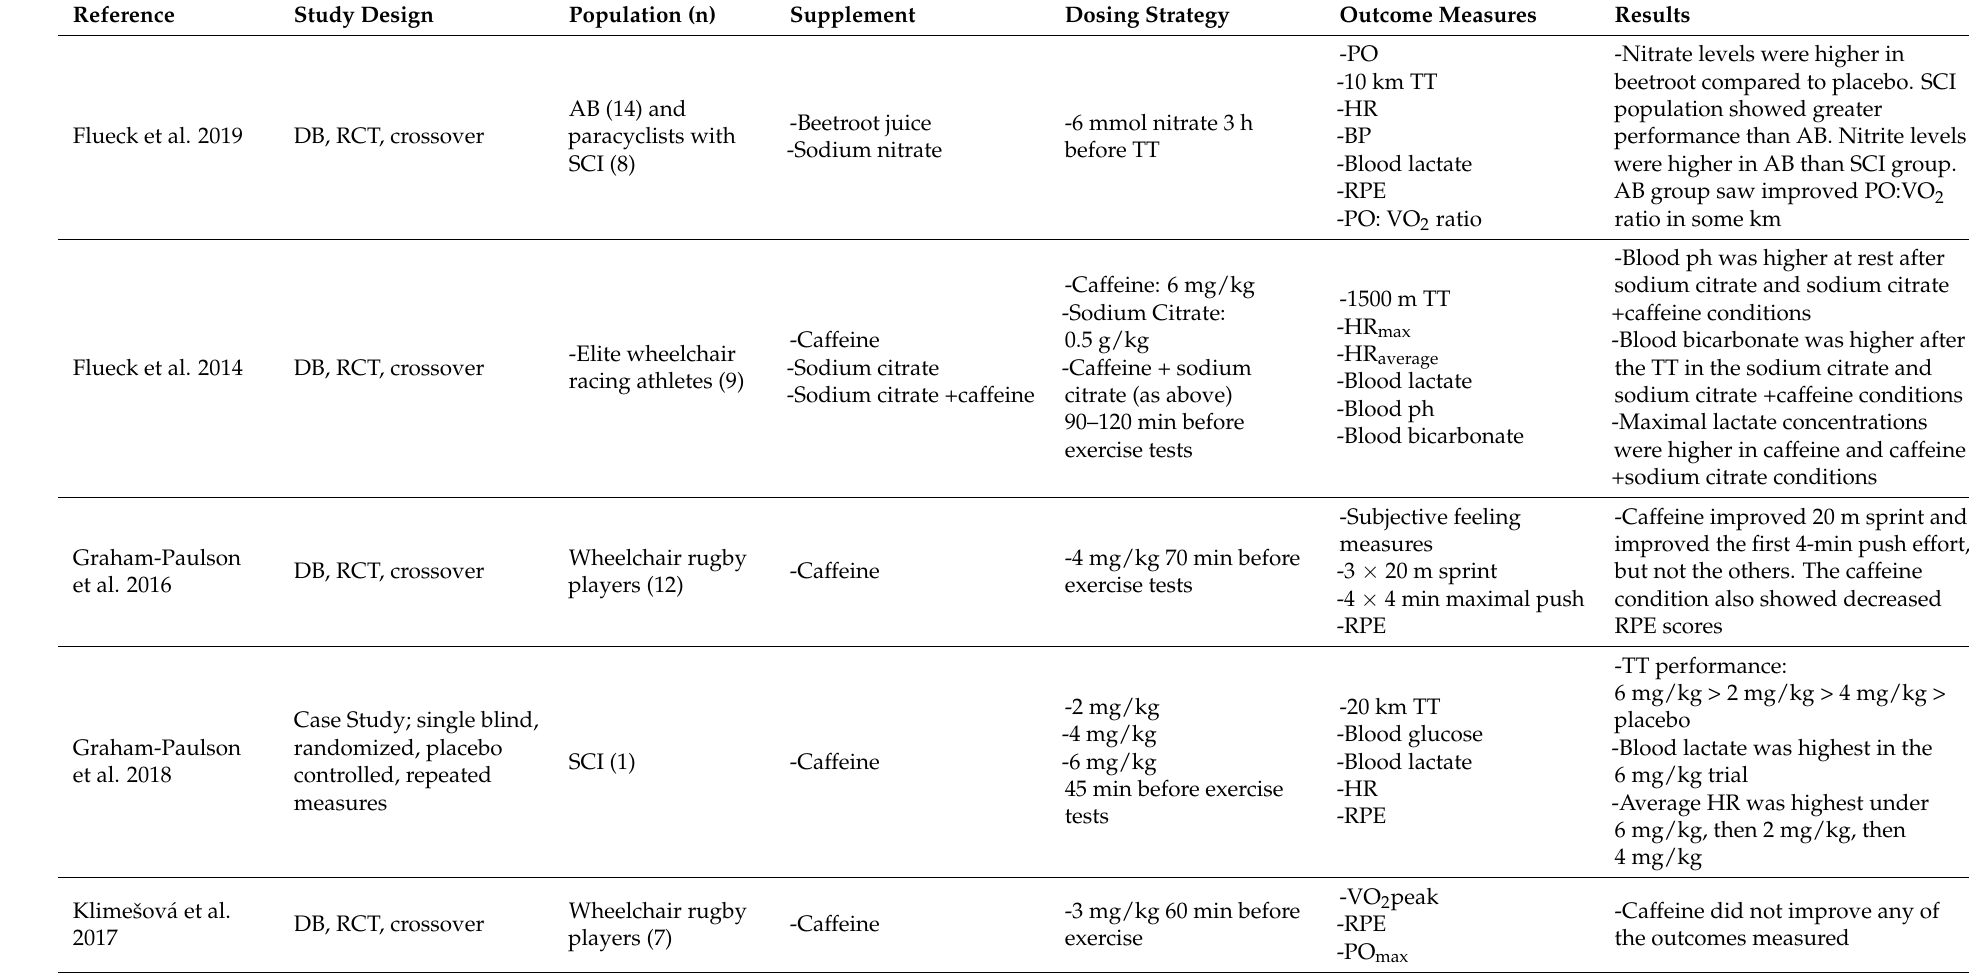
Table 1. Studies involving dietary supplements in